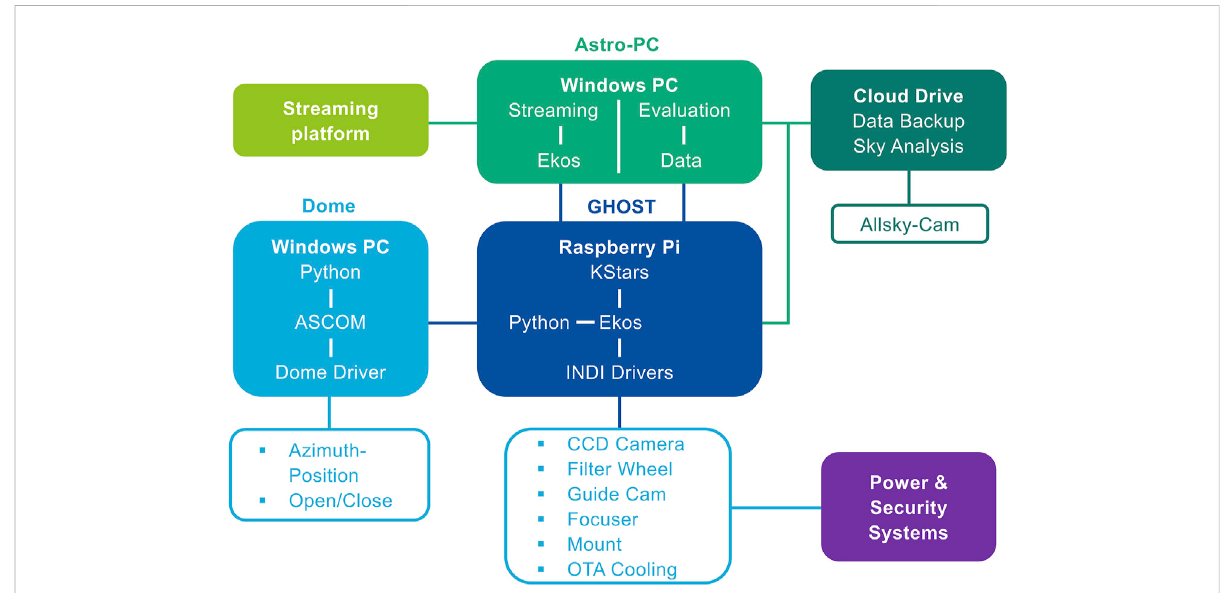
FIGURE 3 Schematic representation of the overall Telescope System “ GHOST ” including the controlling Raspberry Pi (StellarMate OS 64-bit v1.7.1, 2GB RAM),allcomponentsandtheirindividualpowerandsecuritysystems,theseparatePCcontrollingtheDome,whichisconnectedtotheRaspberryPi over an SSH connection controlled by Python scripts. The telescope components are controlled via the INDI protocol (Figure 2)from KStars/Ekos to the INDI Drivers. Additional systems include the “ Astro-PC ” for Data Reduction and Livestreaming, and the Cloud Drive for storing image data and accessing the Sky Monitoring System, which is operated by an